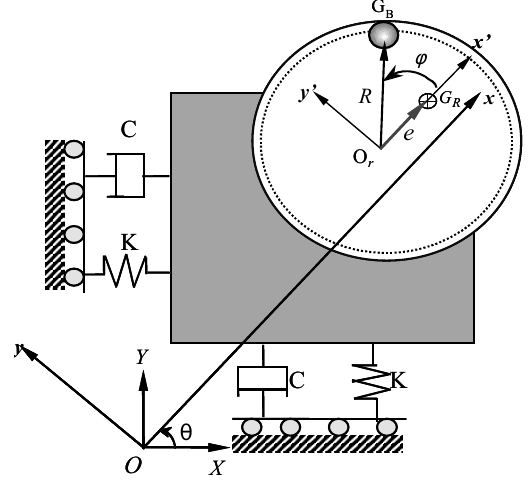
Fig. 2. Frames of reference and the mathematical model of the rotor/balancer